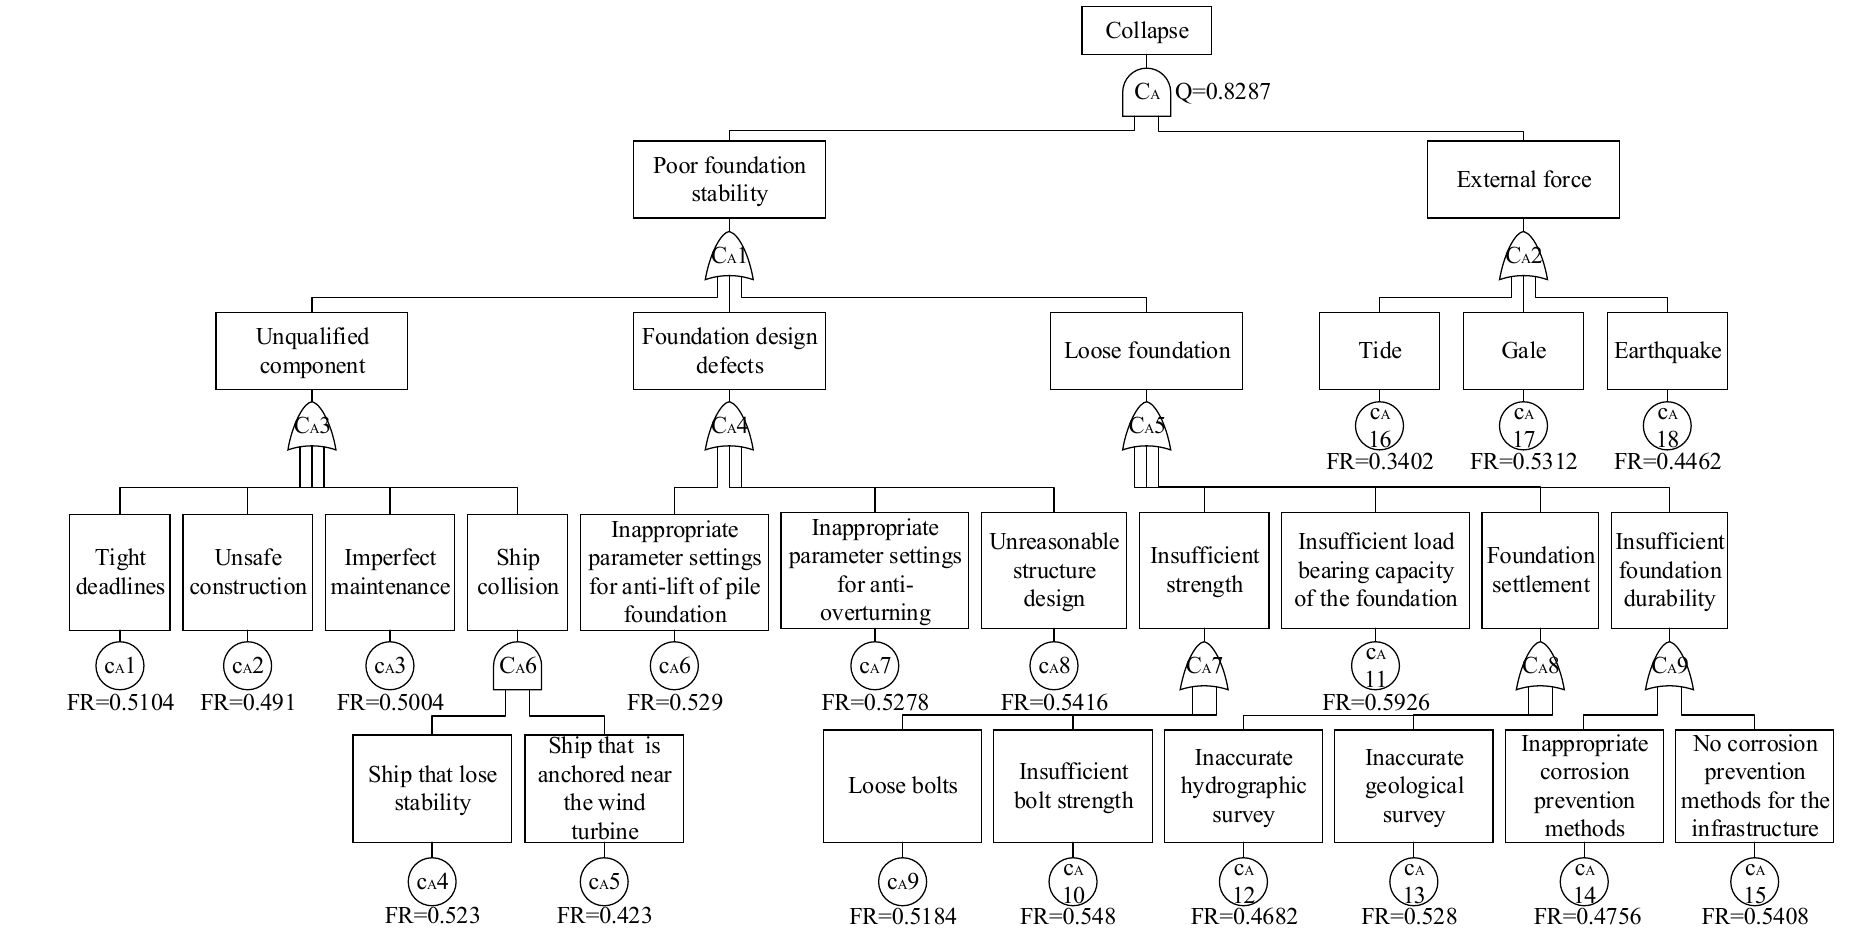
Figure 2. Fault tree analysis model for collapse risk of the offshore wind farm (‘FR’ refers to the risk index of the basic events to the top event. ’Q’ refers to the risk index of the top event to the offshore wind farm during operation).